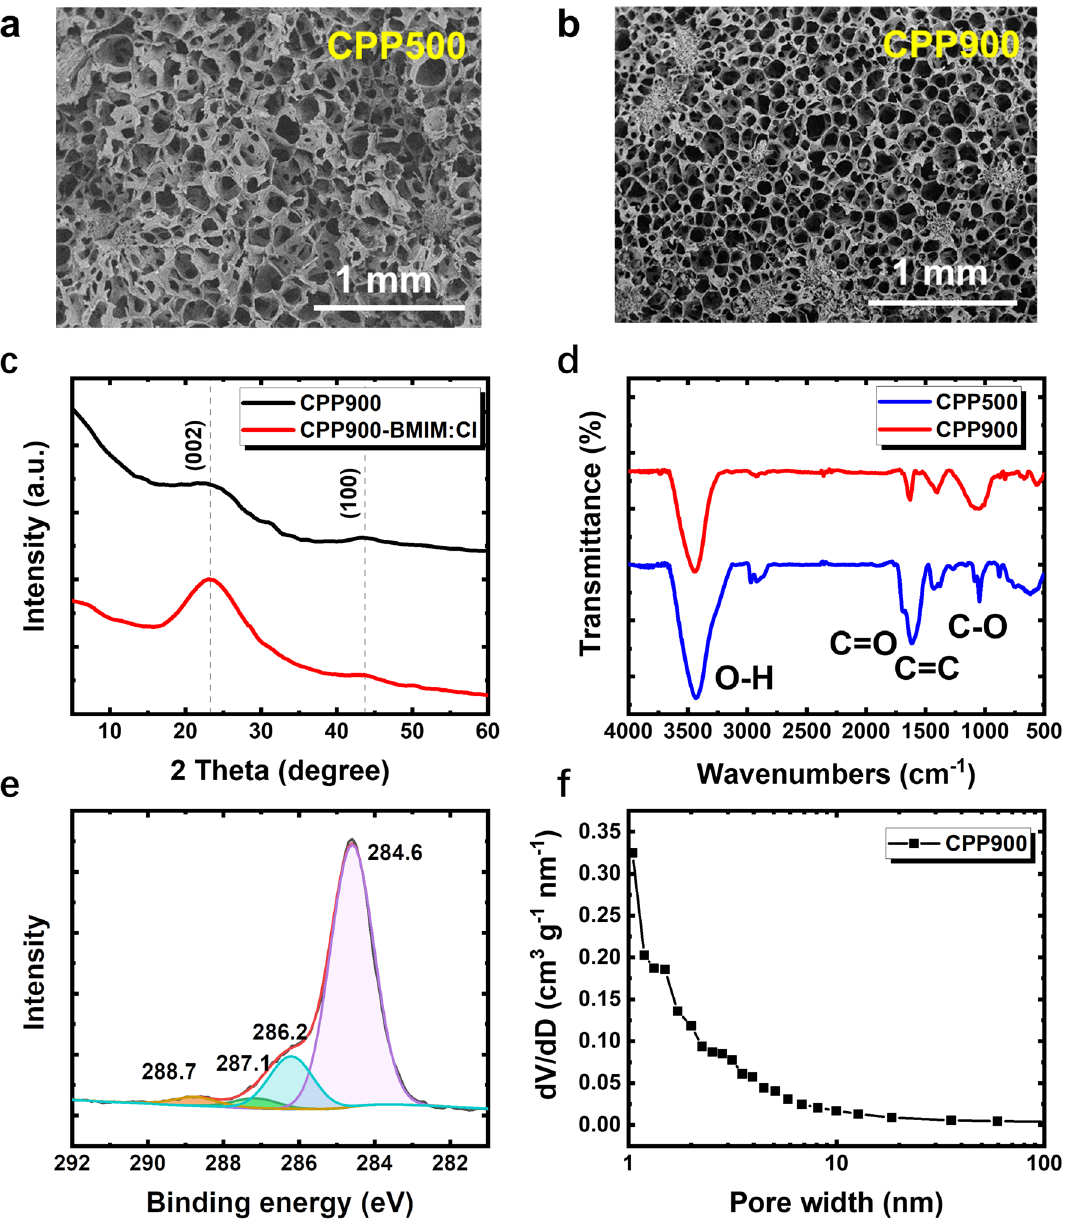
Fig. 3 a , b SEM image of CPP500 and CPP900. The scale bar is 1 mm. c XRD patterns of the CPP900 and CPP900-BMIM:Cl. d FTIR spectra of CPP900 and CPP500. e The C 1s XPS spectra of CPP900-BMIM:Cl. f Pore size distribution of